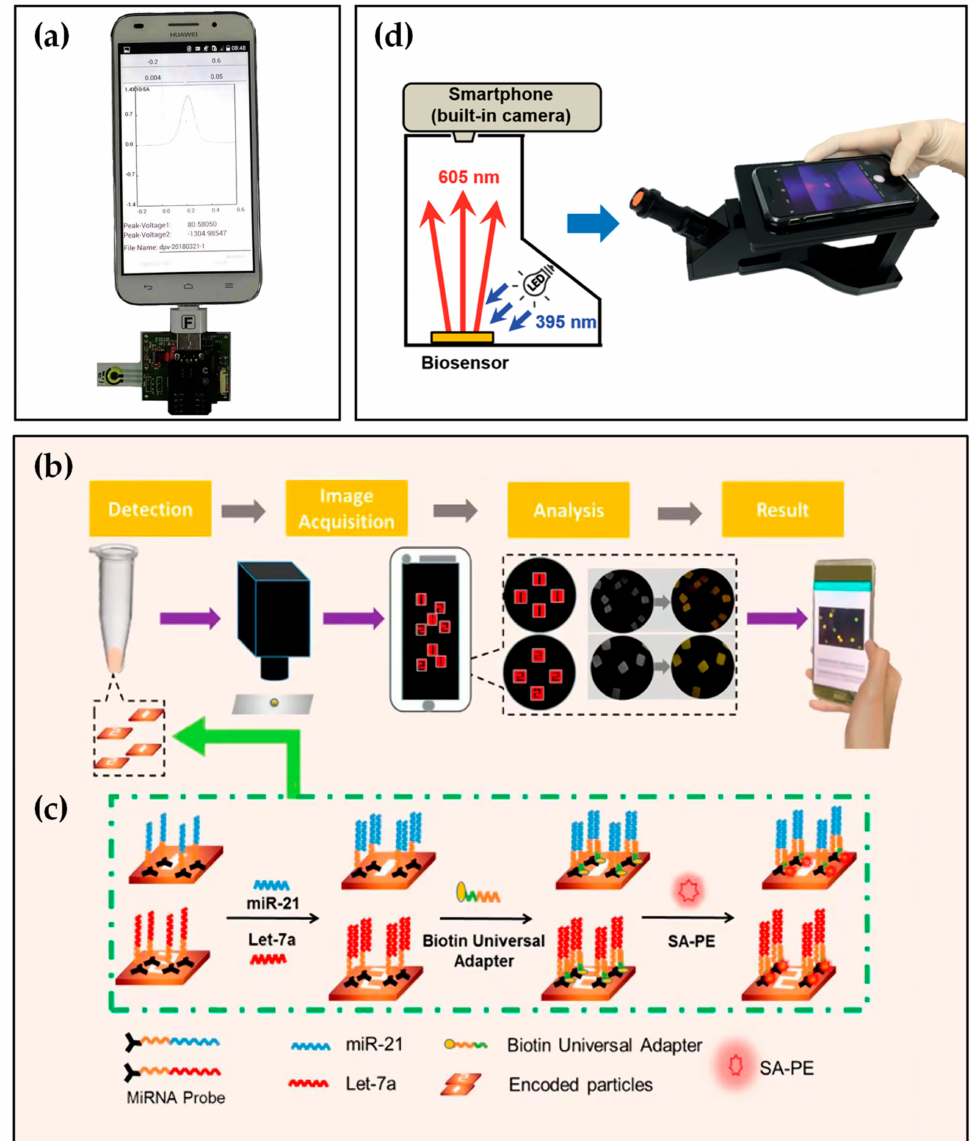
Figure 3. ( a ) Real image of the smartphone-based electrochemical biosensing system for detection of miR-21. Reprinted with permission from Ref. [20], copyright 2020, Elsevier. ( b , c ) Schematic illustration of the miR-21, let-7a simultaneous detection based on aptamer and smartphone. Reprinted with permission from Ref. [79], copyright 2019, American Chemical Society. ( d ) Internal illustration and appearance of self-made equipment with a smartphone. Reprinted with permission from Ref. [73], copyright 2018, Royal Society of